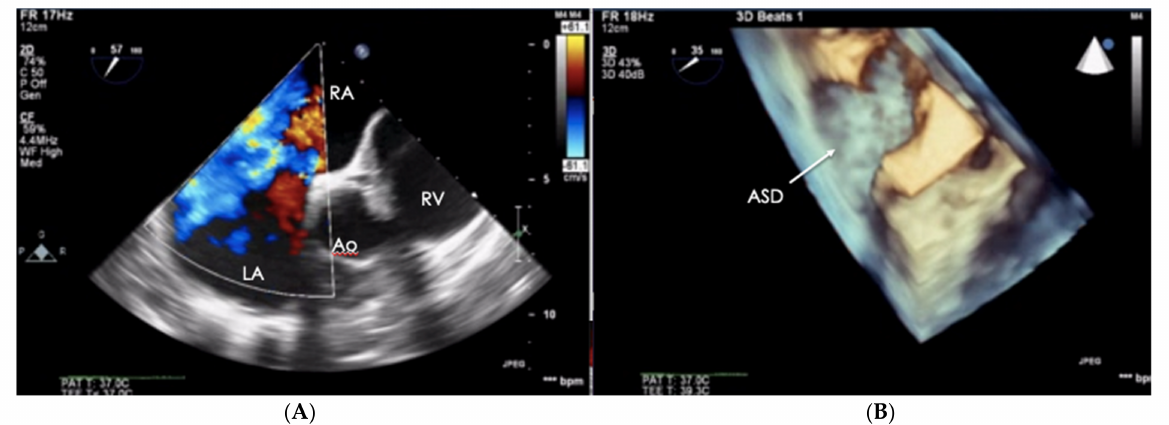
Figure 6. Patient with PAH-CHD–atrial septal defect. (A) 2D-TTE visualization, short-axis view (SAX). ( B ) The same defect visualized in the transthoracic echo (TTE), 3D visualization. PAH-CHD: pulmonary arterial hypertension-congenital heart disease; 2D-TTE: two-dimensional transthoracic echocardiography.